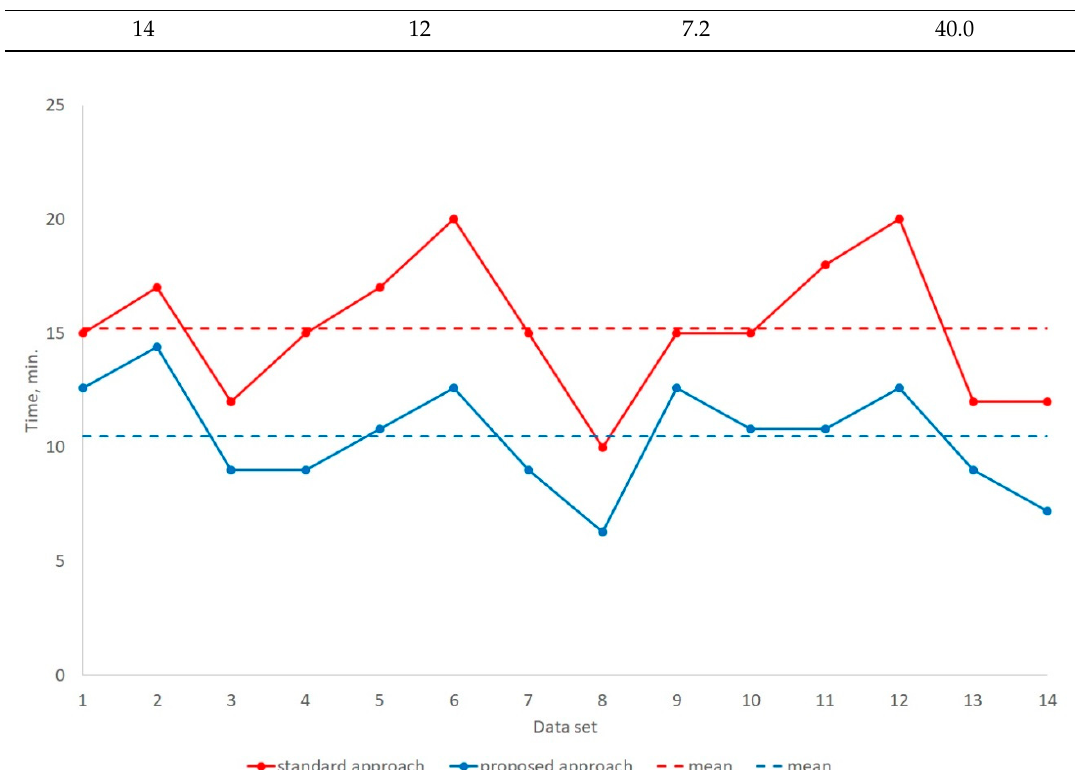
Figure 6. Measurement results of search of analogues runtime by